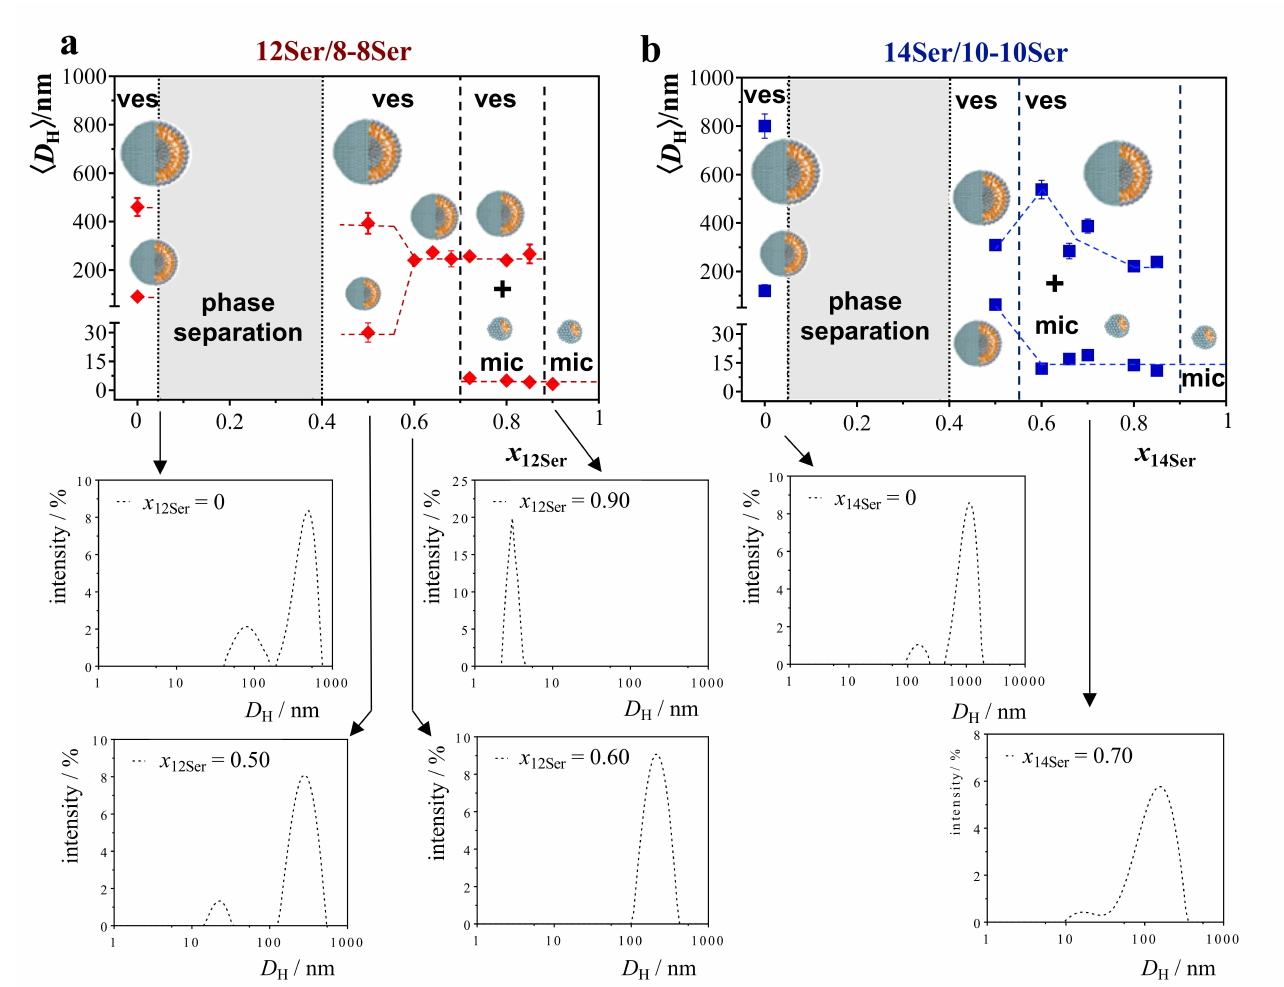
Figure 3. Plots of the average hydrodynamic diameter of the aggregates as measured by DLS vs. molar fraction of cationic surfactant for the two mixtures: ( a ) 12Ser/8-8Ser and ( b ) 14Ser/10-10Ser. For some compositions, the DLS (intensity-weighted) size distributions are shown: x Ser12 = 0, 0.50, 0.60 and 0.90 for 12Ser/8-8Ser; x Ser14 = 0 and 0.50 for